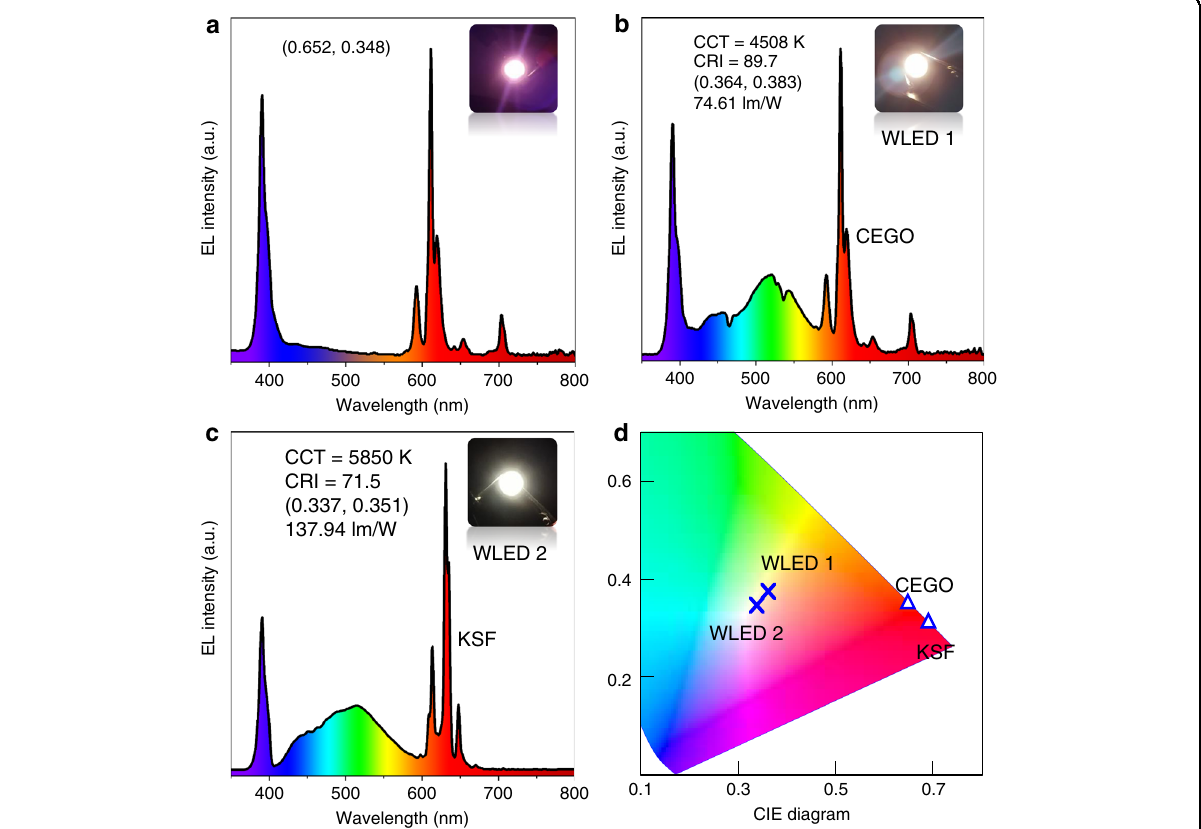
Fig. 7 pc-WLEDs applications for CEGO. EL spectra and device photos of ( a ) CEGO + n-UV chip, ( b ) pc-WLED-1 device (n-UV chip + blue BAM:Eu 2 + + green (BaSr) 2 SiO 4 :Eu 2 + + red CEGO) and ( c ) pc-WLED-2 (n-UV chip + blue BAM:Eu 2 + + green (BaSr) 2 SiO 4 :Eu 2 + + red K 2 SiF 6 :Mn 4 + ). d CIE chromaticity coordinate diagram of two pc-WLED devices and red